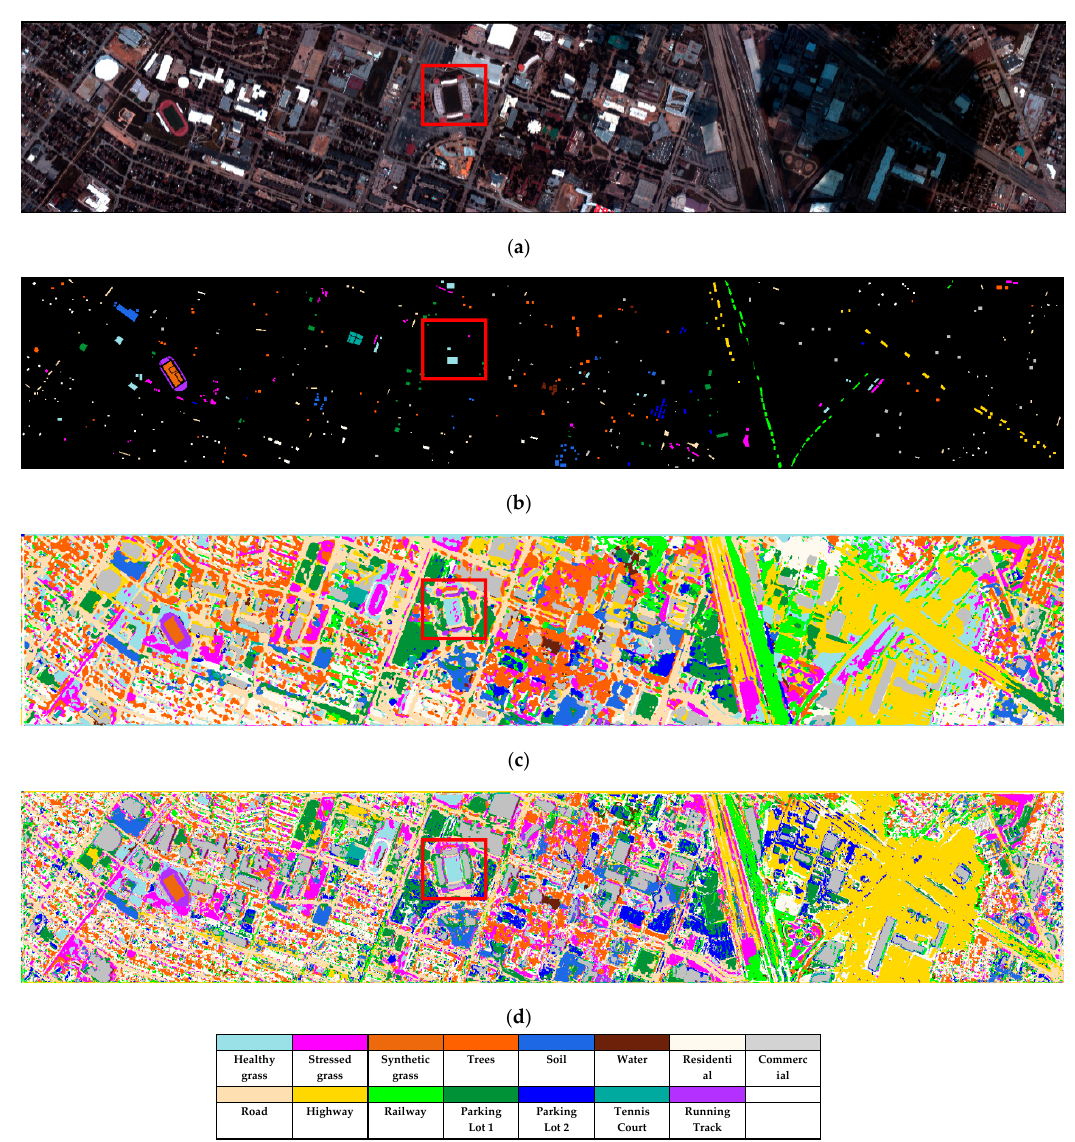
Figure 8. Classification maps of University of Houston dataset. ( a ) True color image. ( b ) Reference image. ( c ) SSRN. ( d ) MSDN-SA.